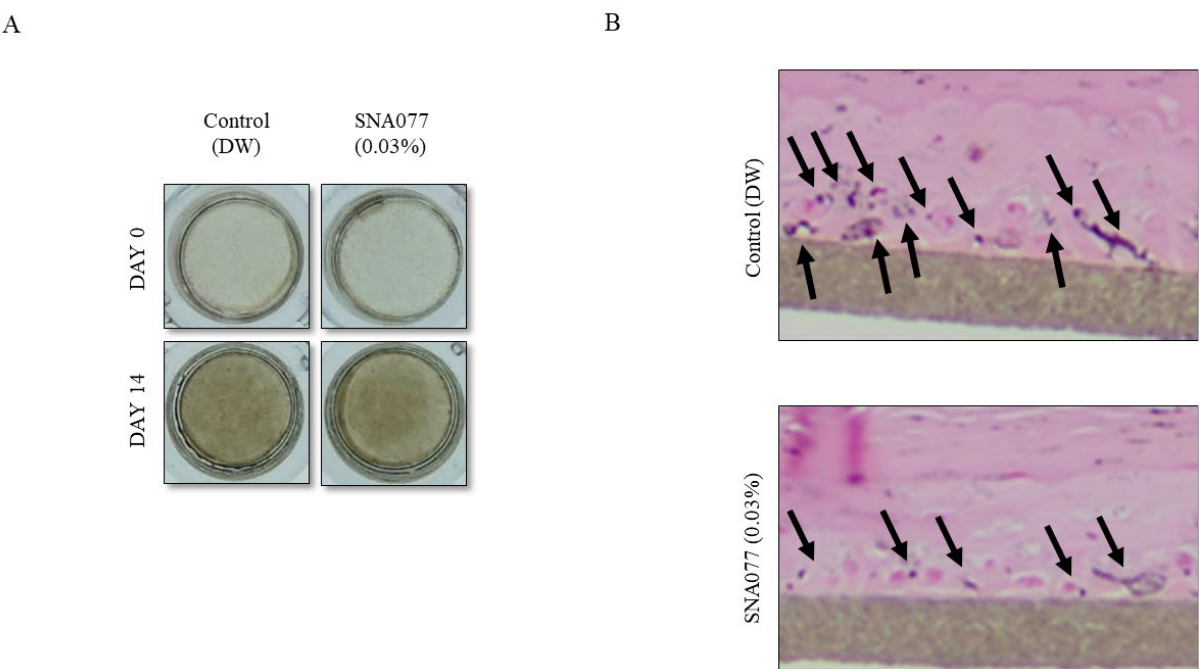
Figure 6. Inhibitory effect of SNA077 on the pigmented human skin model, MelanoDerm. ( A , B ) Skin whitening effects of SNA077 on a 3D pigmented epidermis skin model. MelanoDerm was treated with different concentrations of SNA077 for 14 days, and epidermal pigmentation was assessed by optical evaluation ( A ) and histological analysis using a Fontana Masson’s staining kit ( B ).